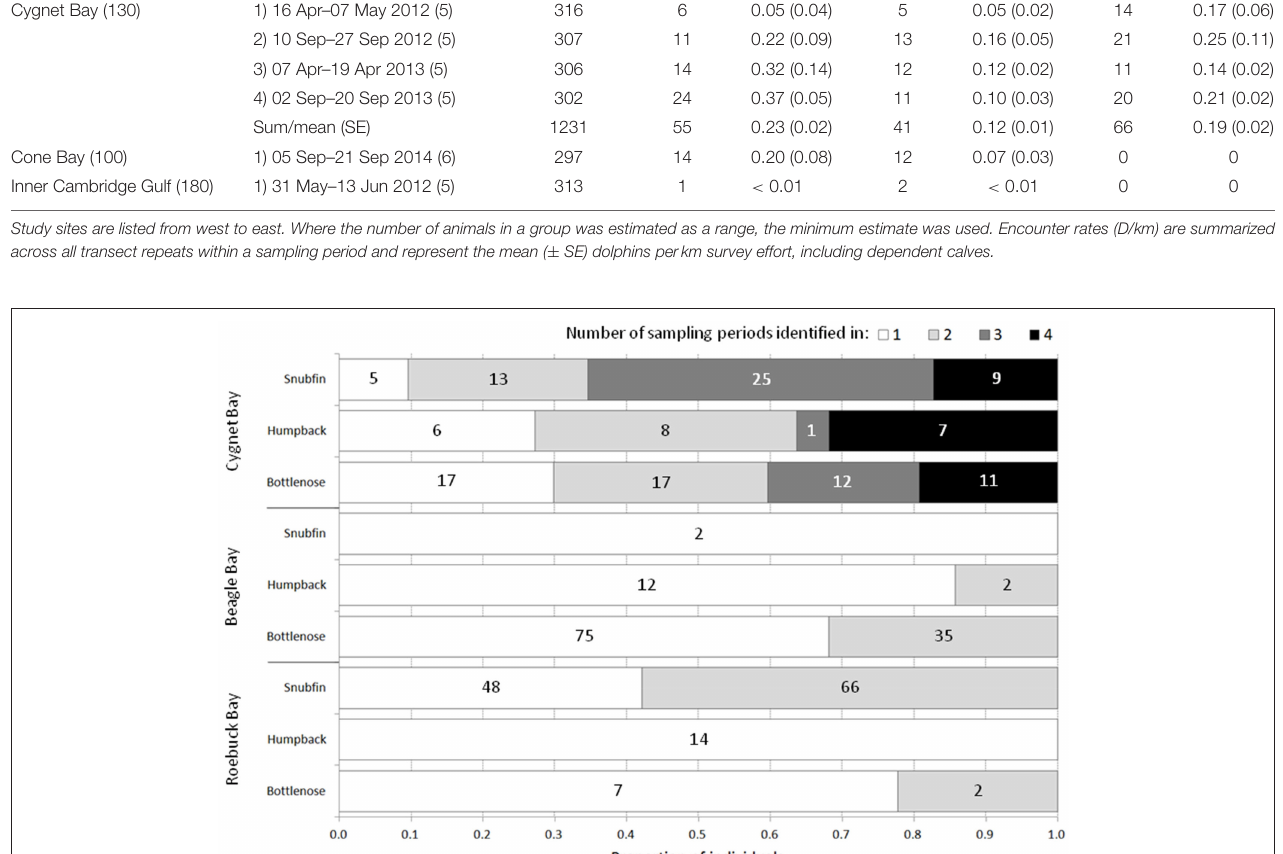
Abundance estimates for snubfin dolphins at both Cygnet and Roebuck Bays were stable across sampling periods at